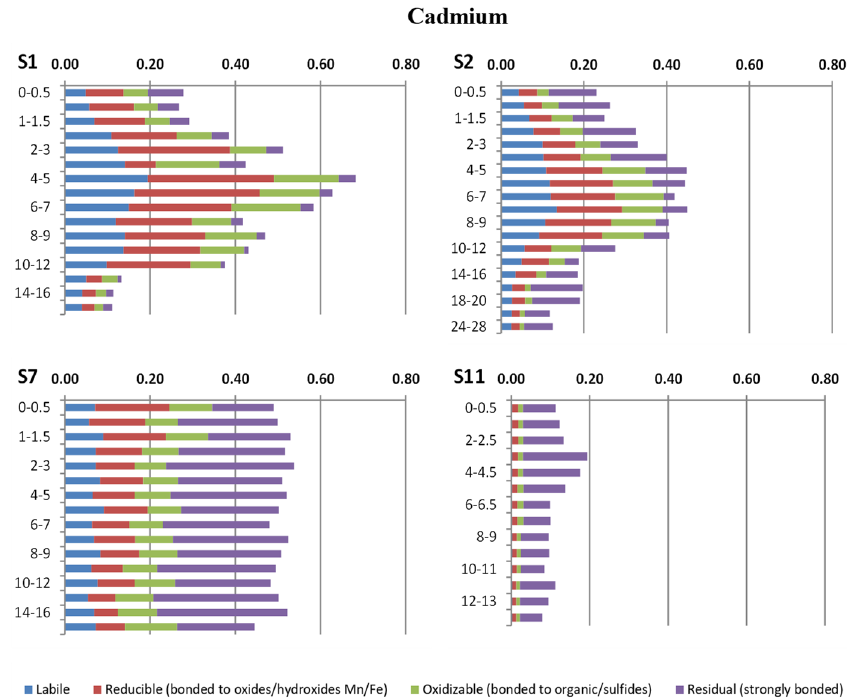
Figure 7. Chemical fractionation of Mo in sediments from the S1, S2, S7, and S11 stations. Horizontal axis: concentration (mg/kg). Vertical axis: core depth (cm).